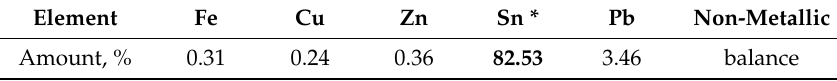
Figure 6. XRD pattern of extracted suspended particles. Table 5. Chemical composition of extracted suspended particles.